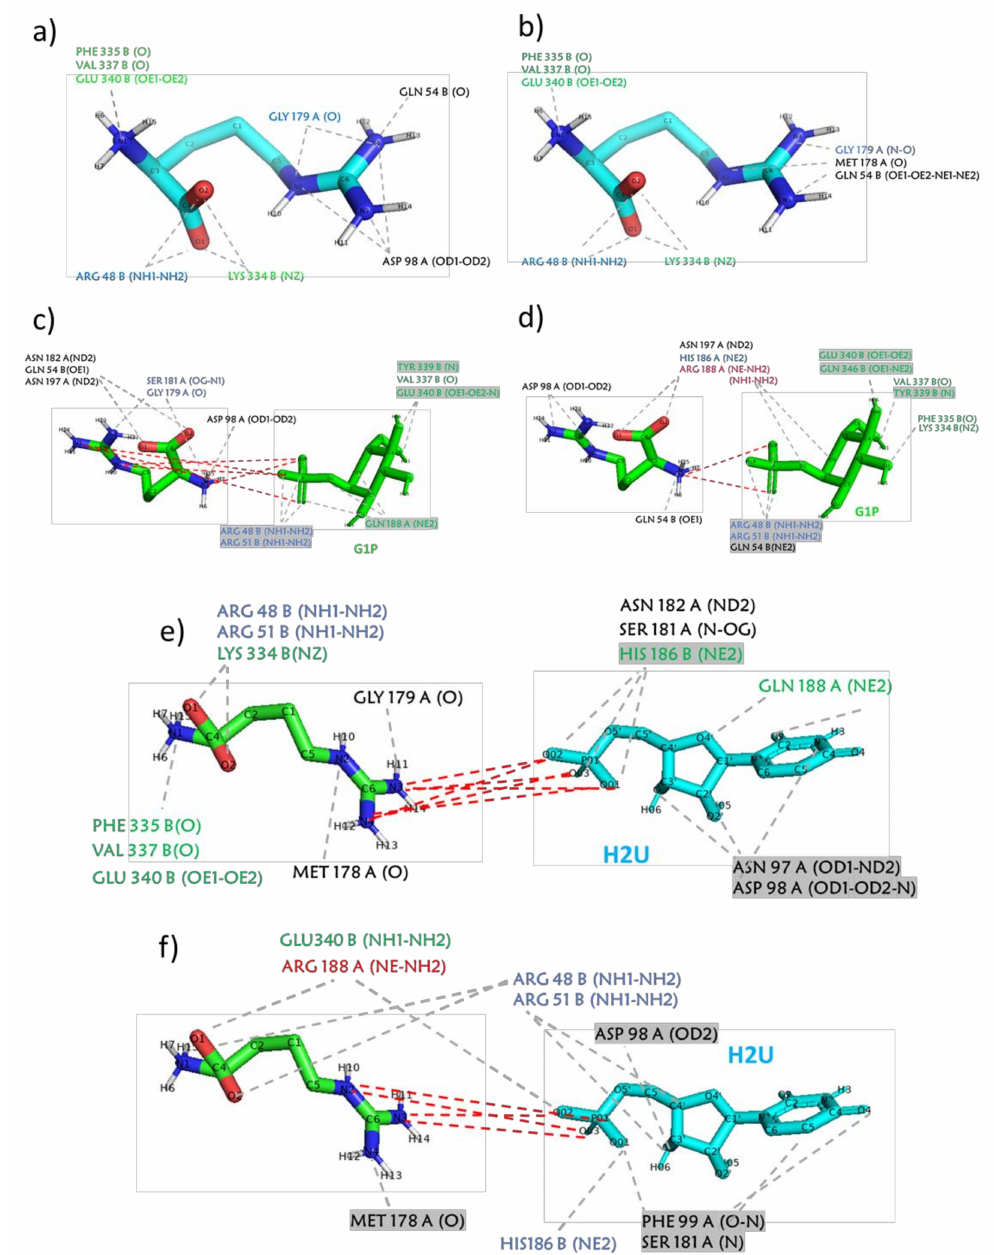
Figure 2. Interactions of arginine in the active site with enzyme and ligands. ( a ) wtGALT + arginine; ( b ) p.Gln188Arg + arginine; ( c ) wtGALT + G1P + arginine; ( d ) p.Gln188Arg + G1P + arginine; ( e ) wtGALT + H2U + arginine; ( f ) p.Gln188Arg + H2U + arginine. Gray background indicates interactions that persisted for more than 50% of the simulation time. Gray dashed lines indicate H-bonds. Red dashed lines indicate interactions between the